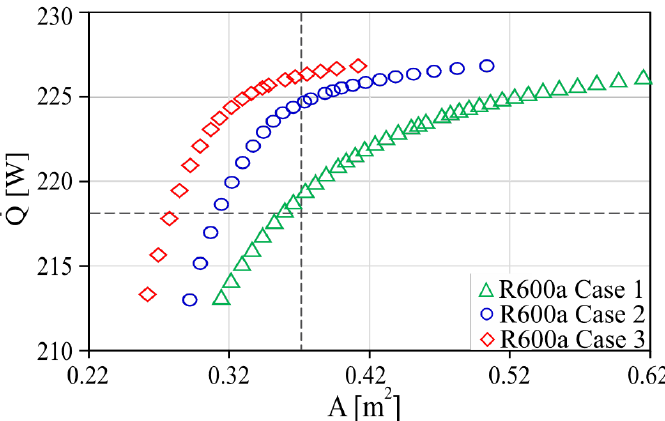
Figure 5. Results of the optimization of the wire-on-tube condenser using R600a.